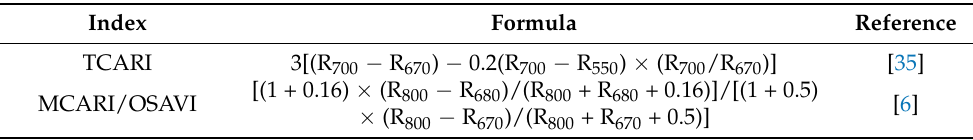
Table 1. Spectral vegetation indices used in this